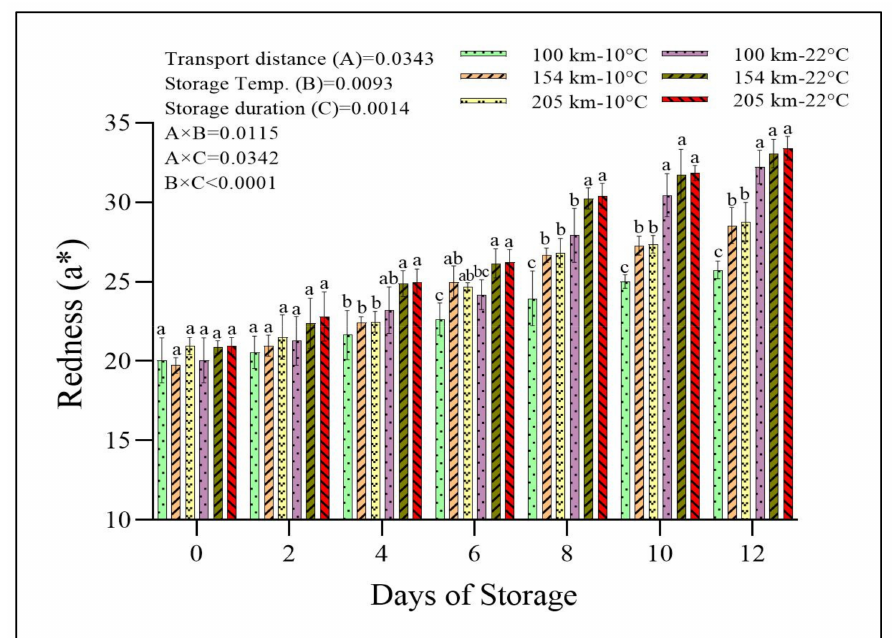
Figure 6. a* value of tomatoes from three different distances stored at (A) 10 ± 0.5 ◦ C (95 ± 1% RH) and (B) 22 ± 1 ◦ C (65 ± 5% RH) for 12 days. Error bars represent standard error (SE) of the mean values ± S.E. of 25 measurements (readings) of 5 tomato replicates. Bars with different letters (per day) are significantly different ( p < 0.05) performed by the Tukey HSD test and numerical values of A, B, and C are p